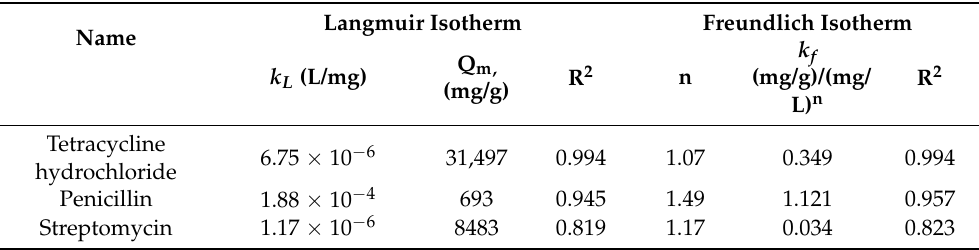
Figure 4. The Langmuir isotherms and Freundlich isotherms for streptomycin, penicillin, and tetracycline hydrochloride adsorption on MCNs at 37 °C. Table 1. The parameters of Langmuir and Freundlich isotherm of three antibiotics’ adsorption on MCNs.